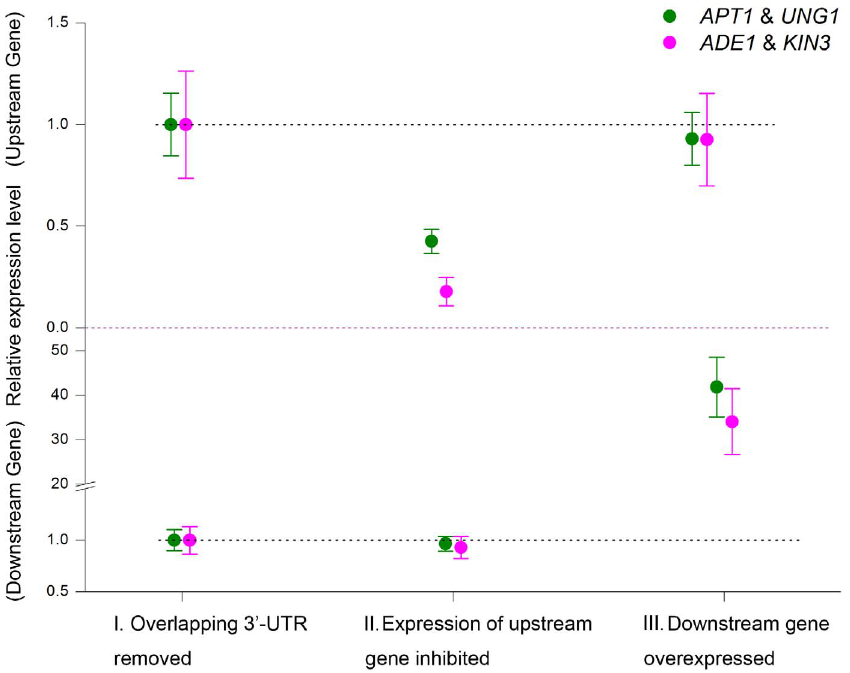
Figure 3. Loss of anti-regulation in the absence of overlapping 3 9 -UTRs. Expression levels of the upstream and downstream genes of two convergent gene pairs with their overlapping 3 9 -UTRs removed. Mean and standard deviation based on three replicates are given for the expression levels: (I) for a baseline control, assigned a value of 1.0; (II) with inhibition of the upstream gene; or (III) with over-expression of the downstream gene.